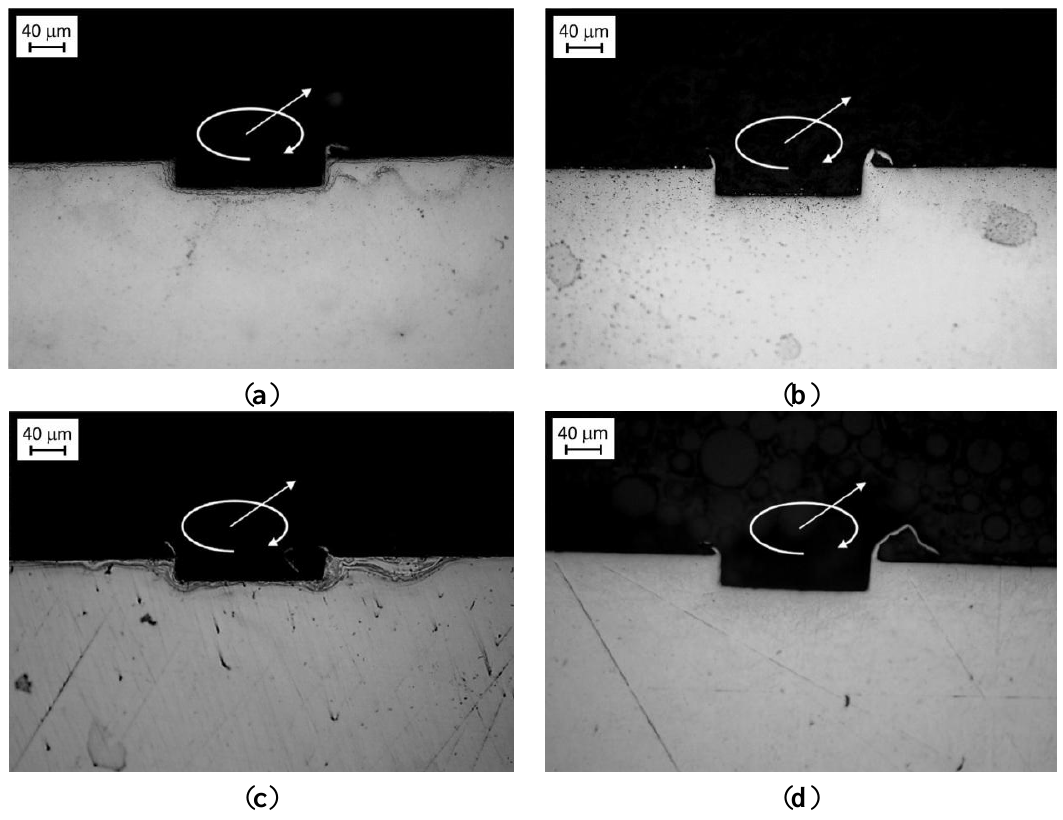
Figure 9. Optical microscope images of micro channel sections (feed-per-tooth 1.5 μm/tooth). ( a ) bimodal; ( b ) fully equiaxed; ( c ) fully lamellar and ( d ) mill annealed. The arrows show the feed and the rotation directions of the